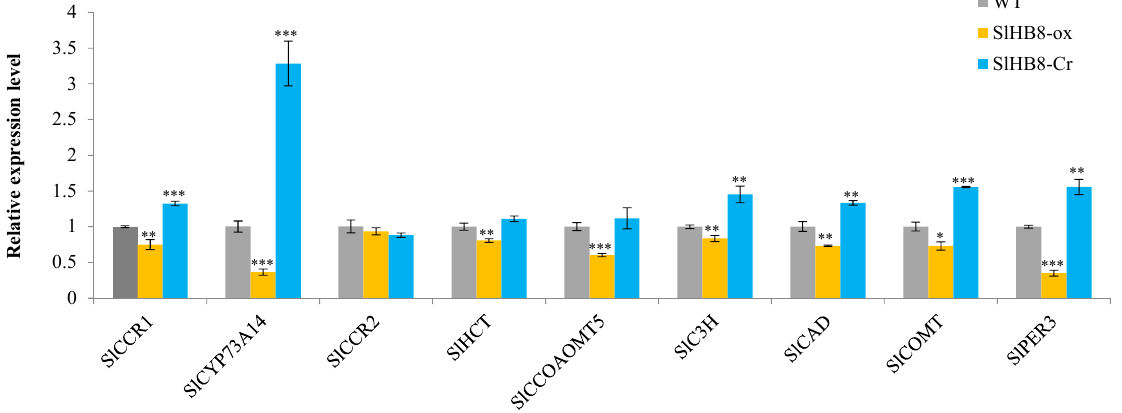
Figure 6. SlHB8 regulates the expression of the phenylpropanoid biosynthesis pathway. The expression pattern of key genes of lignin synthesis pathway in the leaves of WT, SlHB8-ox and SlHB8-cr plants were analyzed by RT-qPCR. In the chart, the gray columns represent the wildtype line, the orange columns represent the 35S-driven SlHB8 overexpression (35sL2) line, and the blue columns represent the SlHB8 knockout (SlHB8-cr2) line. Error bars mean ± standard deviant [SE] and stars indicate the statistical significance. Student’s t -test: * p -value < 0.05, ** p -value < 0.01, *** p -value < 0.001.